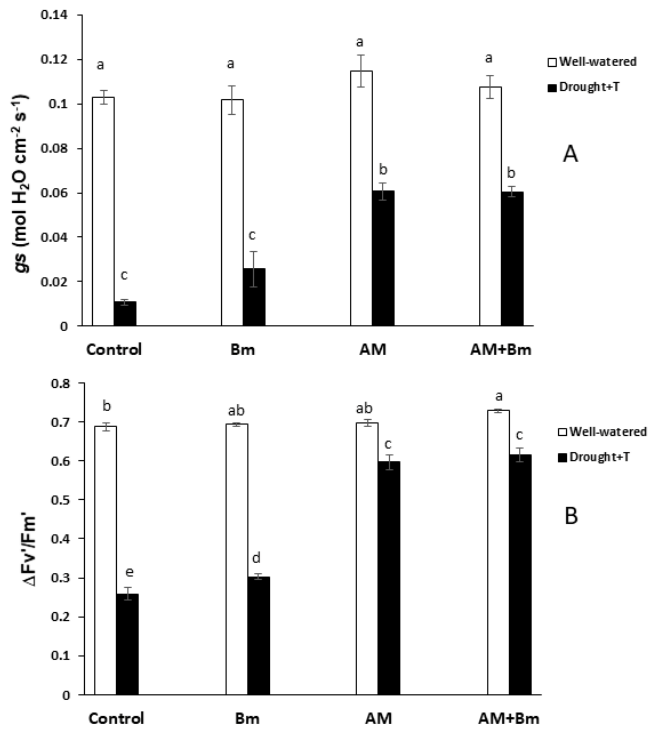
Figure 3. ( A ) Stomatal conductance (gs) and ( B ) photosystem II efficiency in the light-adapted state ( Fv/Fm ′ ) in maize plants inoculated or not (control) with a PGPR strain of Bacillus megaterium (Bm), with the arbuscular mycorrhizal fungus Rhizophagus irregularis (AM) or with both microorganisms (AM + Bm). Plants were cultivated under standard ambient temperature and well-watering conditions (well-watered) or subjected to a combined drought and high temperature stress (drought + T) for 15 days before harvest. Data represent the means (n = 8) (gs) or (n = 10) ( Fv/Fm’) ± S.E. Different letters indicate significant differences between treatments ( p < 0.05) based on Tukey–Kramer test.